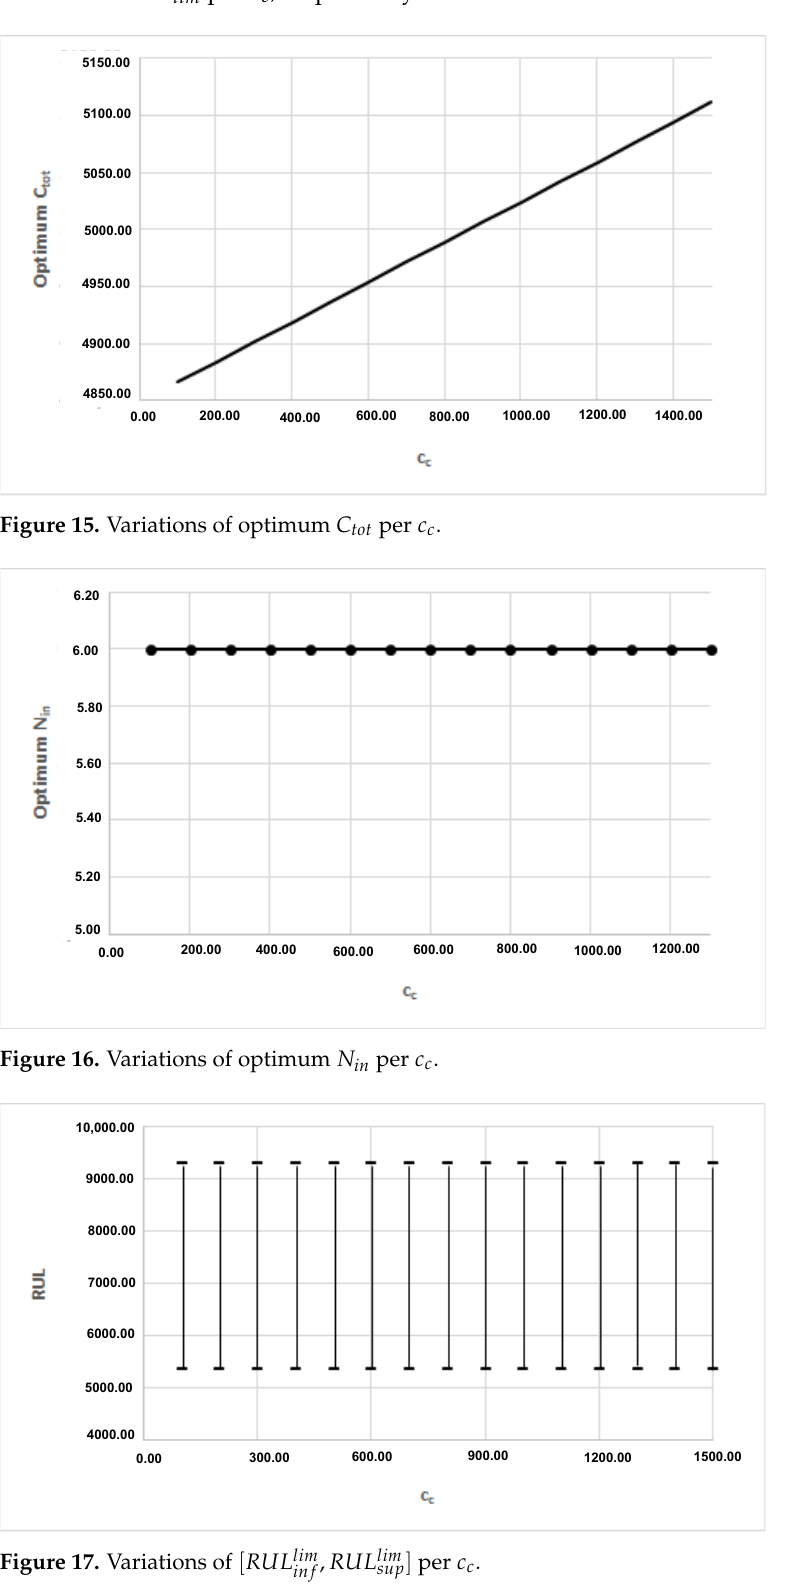
, RUL lim sup ] per c c inf